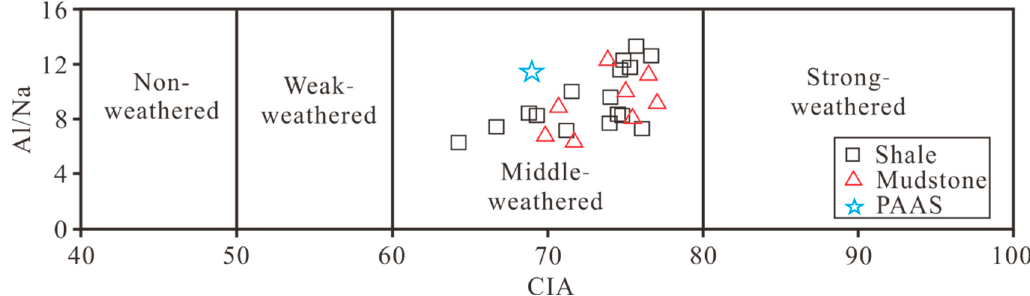
Figure 8. Cross plot of CIA values versus Al/Na ratios demonstrating the weathering degree (the plate after